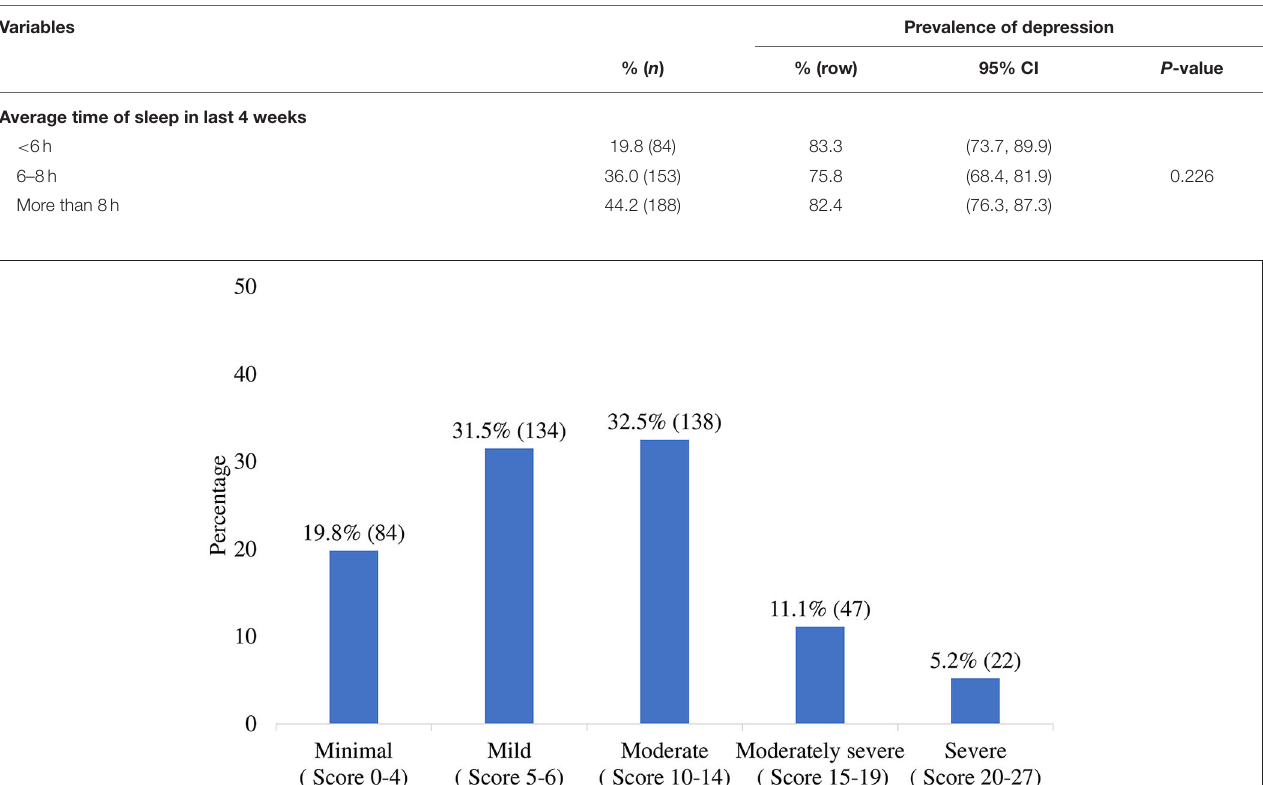
95% CI: 2.6–31.4; Often vs. Never AOR = 7.9, 95% CI: 2.8–21.7; Sometimes vs. Never AOR = 5.6, 95% CI: 2.7–11.5; Occasionally vs. Never AOR = 5.0, 95% CI: 2.3–9.7). Also, students